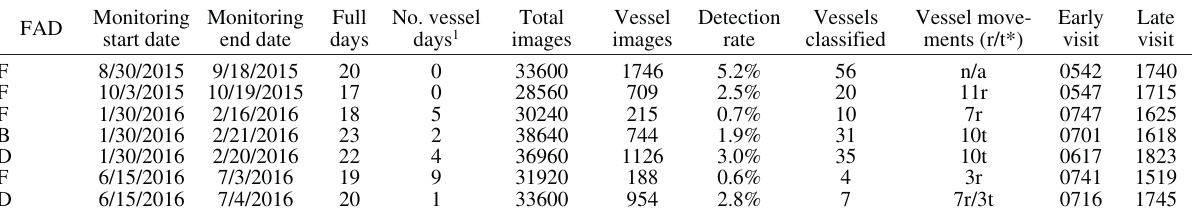
Table 1. – Time-lapse cameras were deployed on three FADs during different times of the year off San Juan, Puerto Rico. 1 No. vessel days is the number of days that a single fishing vessel was not detected at each respective FAD; *r, vessels that were cross-identified and matched between monitoring periods and repeatedly visited; *t, vessels that were cross-identified and matched as transient between FADs during a monitoring period.